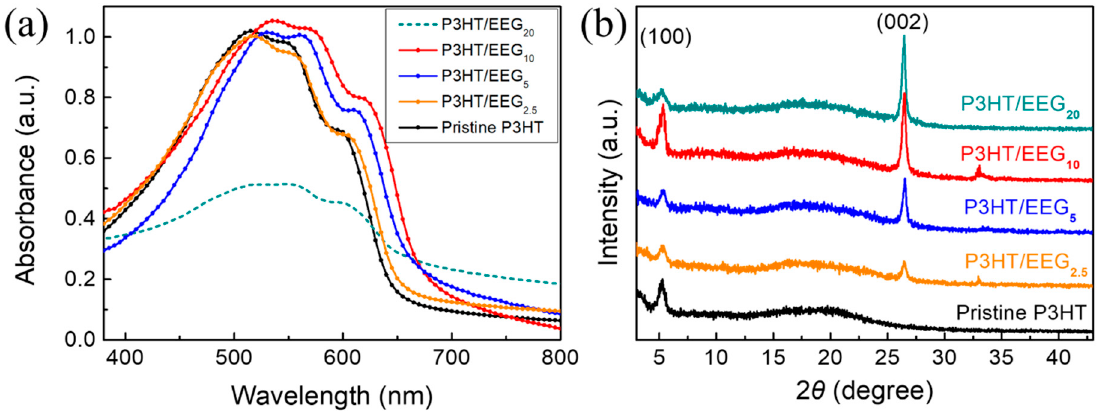
Figure 4. ( a ) UV–Vis spectra and ( b ) XRD patterns of transferred P3HT and P3HT/EEG nanocomposite films via solution-floating method. films via solution-floating